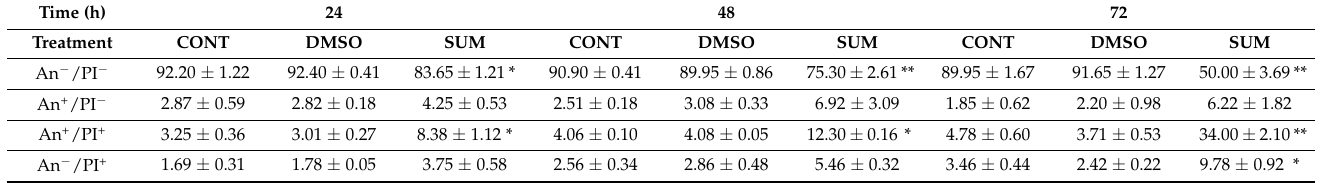
Figure 13. Representative diagrams of apoptotic cell diversification in MDA-MB-231 cells after SUM treatment (215 µg/mL).